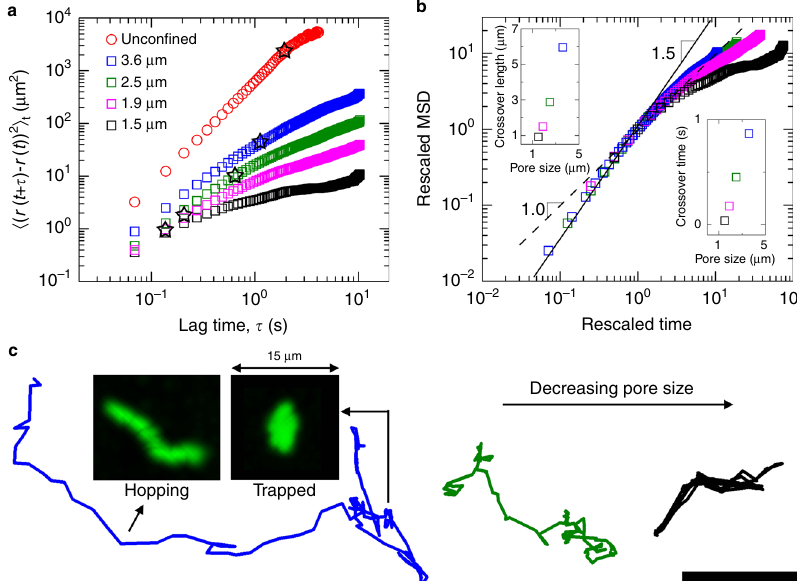
Fig. 2 Bacteria move through 3D porous media via intermittent trapping and hopping. a Ensemble average mean-squared displacement (MSD) as a function of lag time for uncon fi ned bacteria (red) and for bacteria in porous media with increasing amounts of con fi nement (blue, green, magenta, black). Stars indicate deviation from ballistic motion for uncon fi ned bacteria, or deviation from superdiffusive motion for bacteria in porous media. Legend indicates characteristic pore sizes of the different media. b Rescaling by the crossover length and time scales (stars in a ) indicates two regimes of motion for bacteria in porous media: superdiffusive motion at short times with the MSD scaling as τ 1.5 , and subdiffusive motion at long times with the MSD scaling as τ v with the exponent 0 < v ≤ 1 decreasing with pore-scale con fi nement. This behavior is in stark contrast to simple run-and-tumble motion and instead re fl ects intermittent trapping of cells as they move. Insets show crossover lengths and times for different media; crossover lengths do not scale linearly with the measured characteristic pore sizes due to pore-size heterogeneity in the media. c Representative single-cell trajectories reveal switching between two modes of motion: hopping, in which bacteria move through extended, directed paths through the pore space, and trapping, in which bacteria are con fi ned for extended periods of time. Insets show time projections of the cell body in the hopping and trapping state; trapped cells continue to reorient their bodies until they can escape and continue to hop through the pore space. Decreasing the pore size decreases the hop lengths, indicated by the green and black trajectories (characteristic pore sizes are 3.6, 2.5, and 1.5 μ m from left to right). Scale bar represents 10 μ